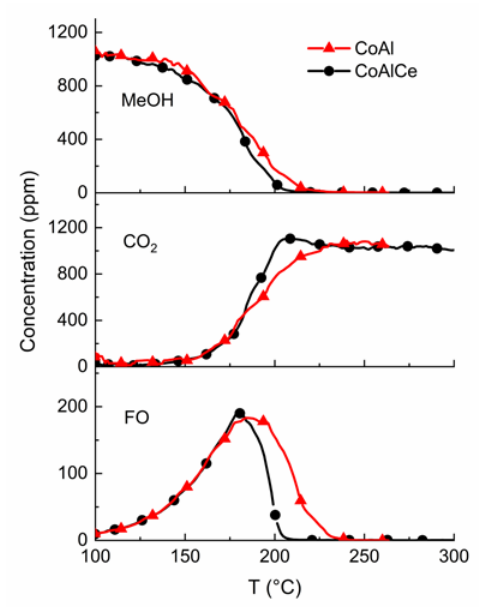
Figure 8. Main products of methanol oxidative dehydrogenation over CoAl and CoAlCe catalysts (in the thermal experiment, no changes were observed in this temperature range). Table 5. Comparisonoflight-offtemperature, 90%conversiontemperature(T 50 andT 90 )andformaldehyde yields in the reactions of methanol and a mixture of methanol and methanethiol over CoAl and CoAlCe